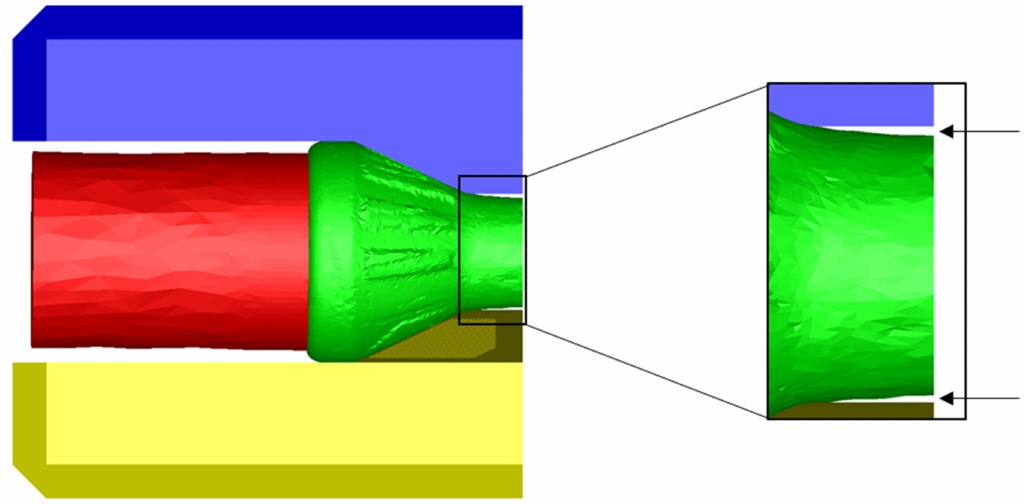
Figure 10. Detachment of the workpiece from the tool during the rolling process due to